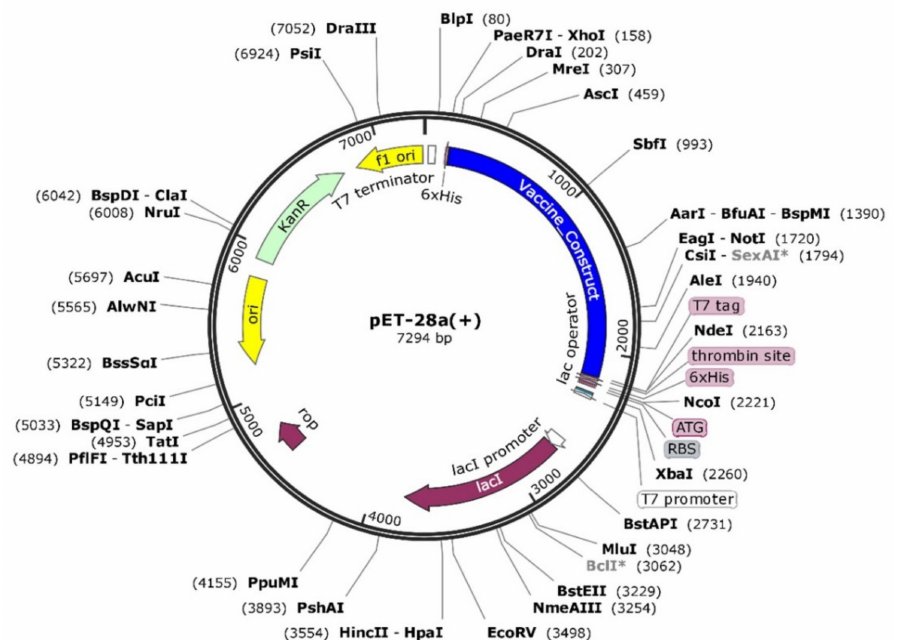
Figure 8. In silico cloning of the vaccine (shown in blue) into the pET28a (+) vector (shown by red color). The calculated CAI value 0.93 and the GC contents 49% shown after codon optimization by JCat